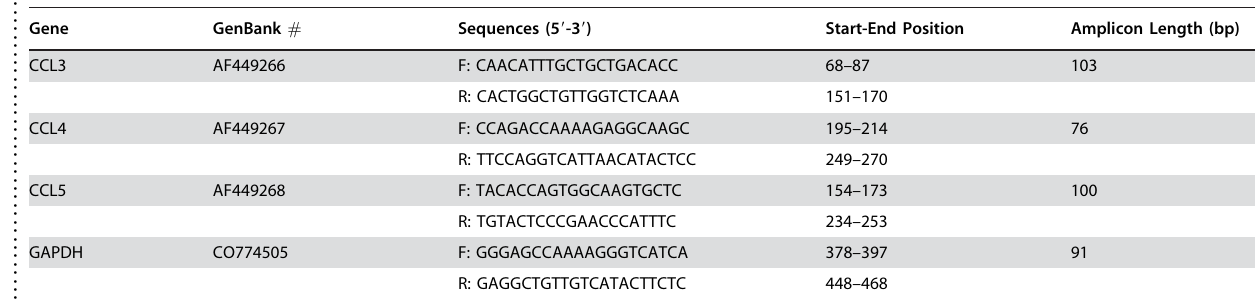
Table 2. Rhesus macaque-specific primers for real-time PCR .. ... .... ... ... .... ... ... .... ... ... .... ... ... .... ... ... .... ... ... .... ... ... .... ... ... .... ... ... .... ... ... .... ... ... .... ... ... .... ... ... .... ... ... . Gene